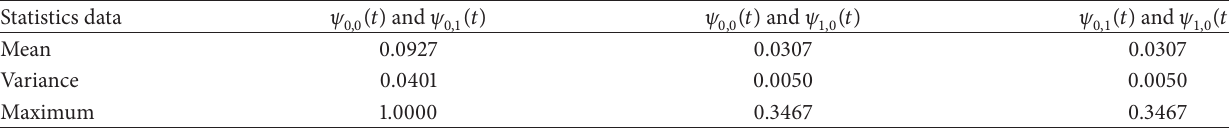
Table 2: Statistics of asynchronous mutual correlation values for db8